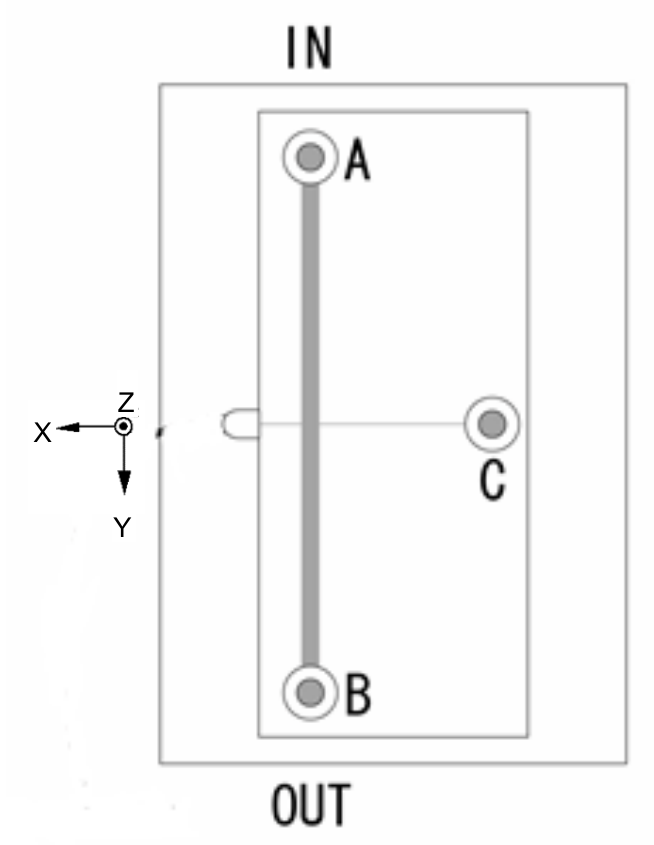
Figure 1. Top view of mini-channel.